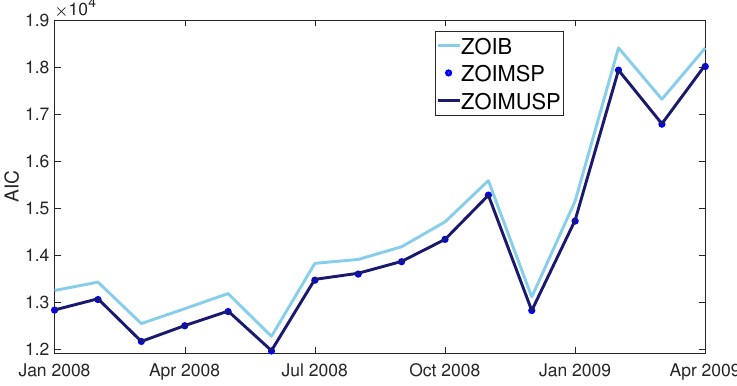
Figure 10. The AIC of the ZOIB as well as ZOIMSP and ZOIMUSP models, plotted for each